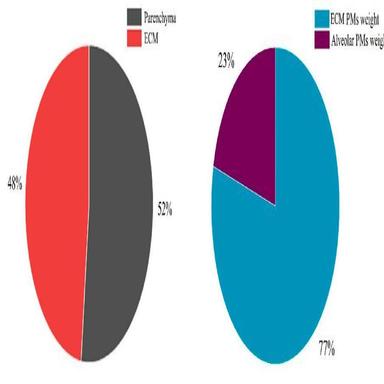
The proportional weight of isolated PMs and tissues.